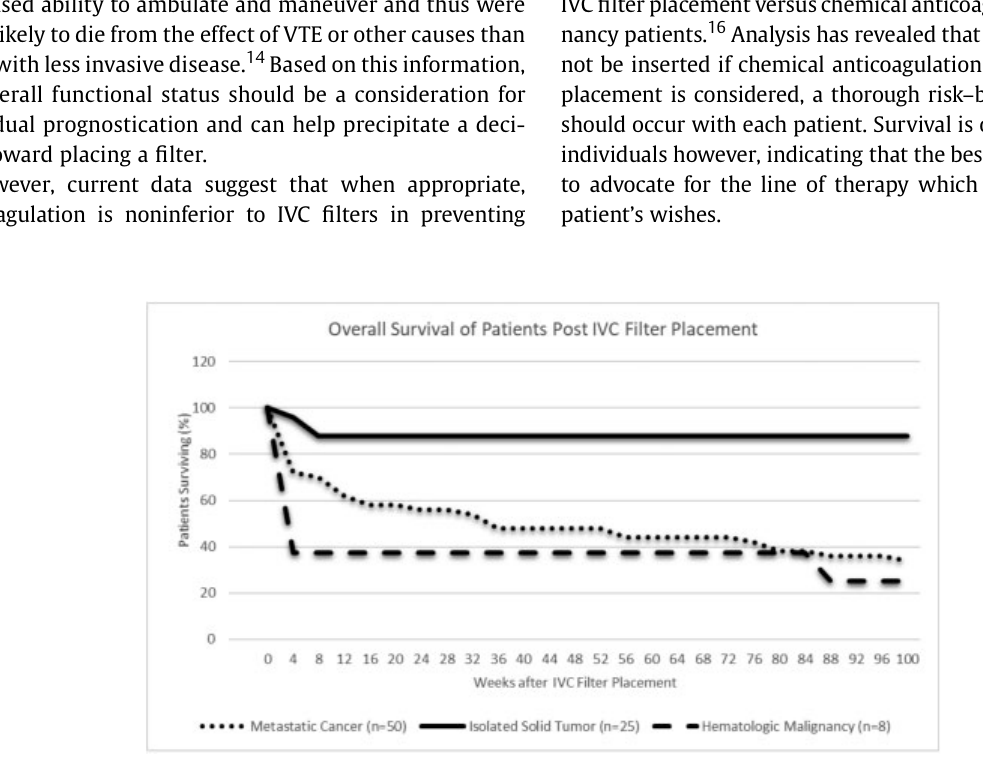
TH Open Vol. 3 No.